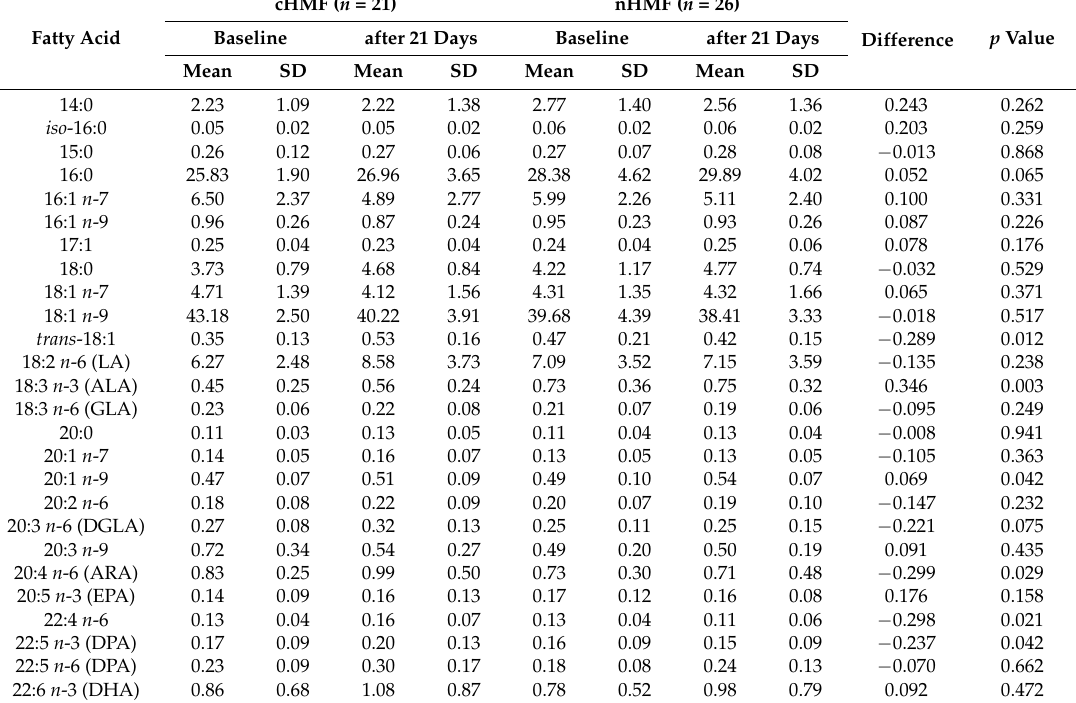
Table 5. Fatty acid profile (g/100 g of fatty acids) of plasma triacylglycerols in preterm infants receiving human milk fortified with a control (cHMF) or with a new human milk fortifier (nHMF), before and after 21 days of treatment. Estimations of the treatment effect nHMF/cHMF (Difference) and the two-sided p -value are given for each fatty acid analysed in the different lipid